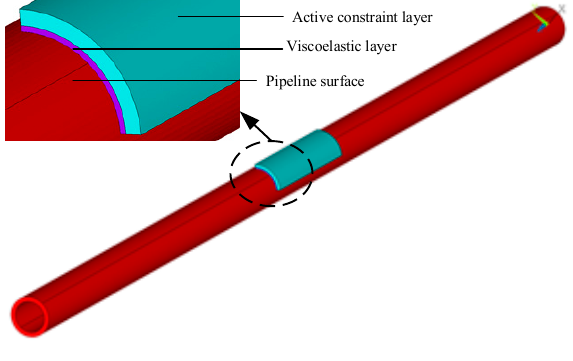
Figure 4. Pipeline with ACLD patch.